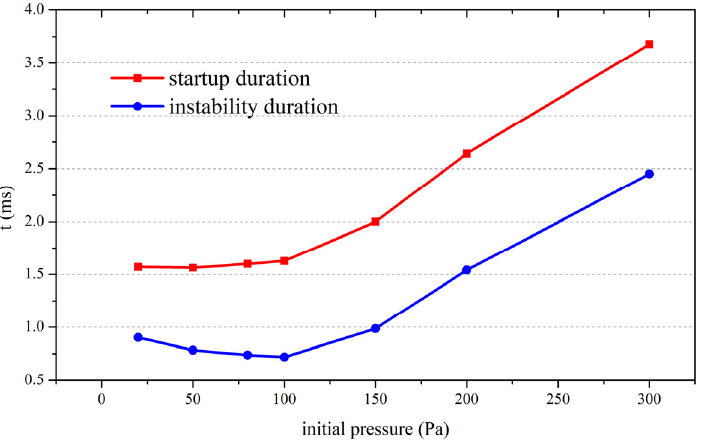
Figure 8. Nozzle center startup and instability duration under different initial pressure.